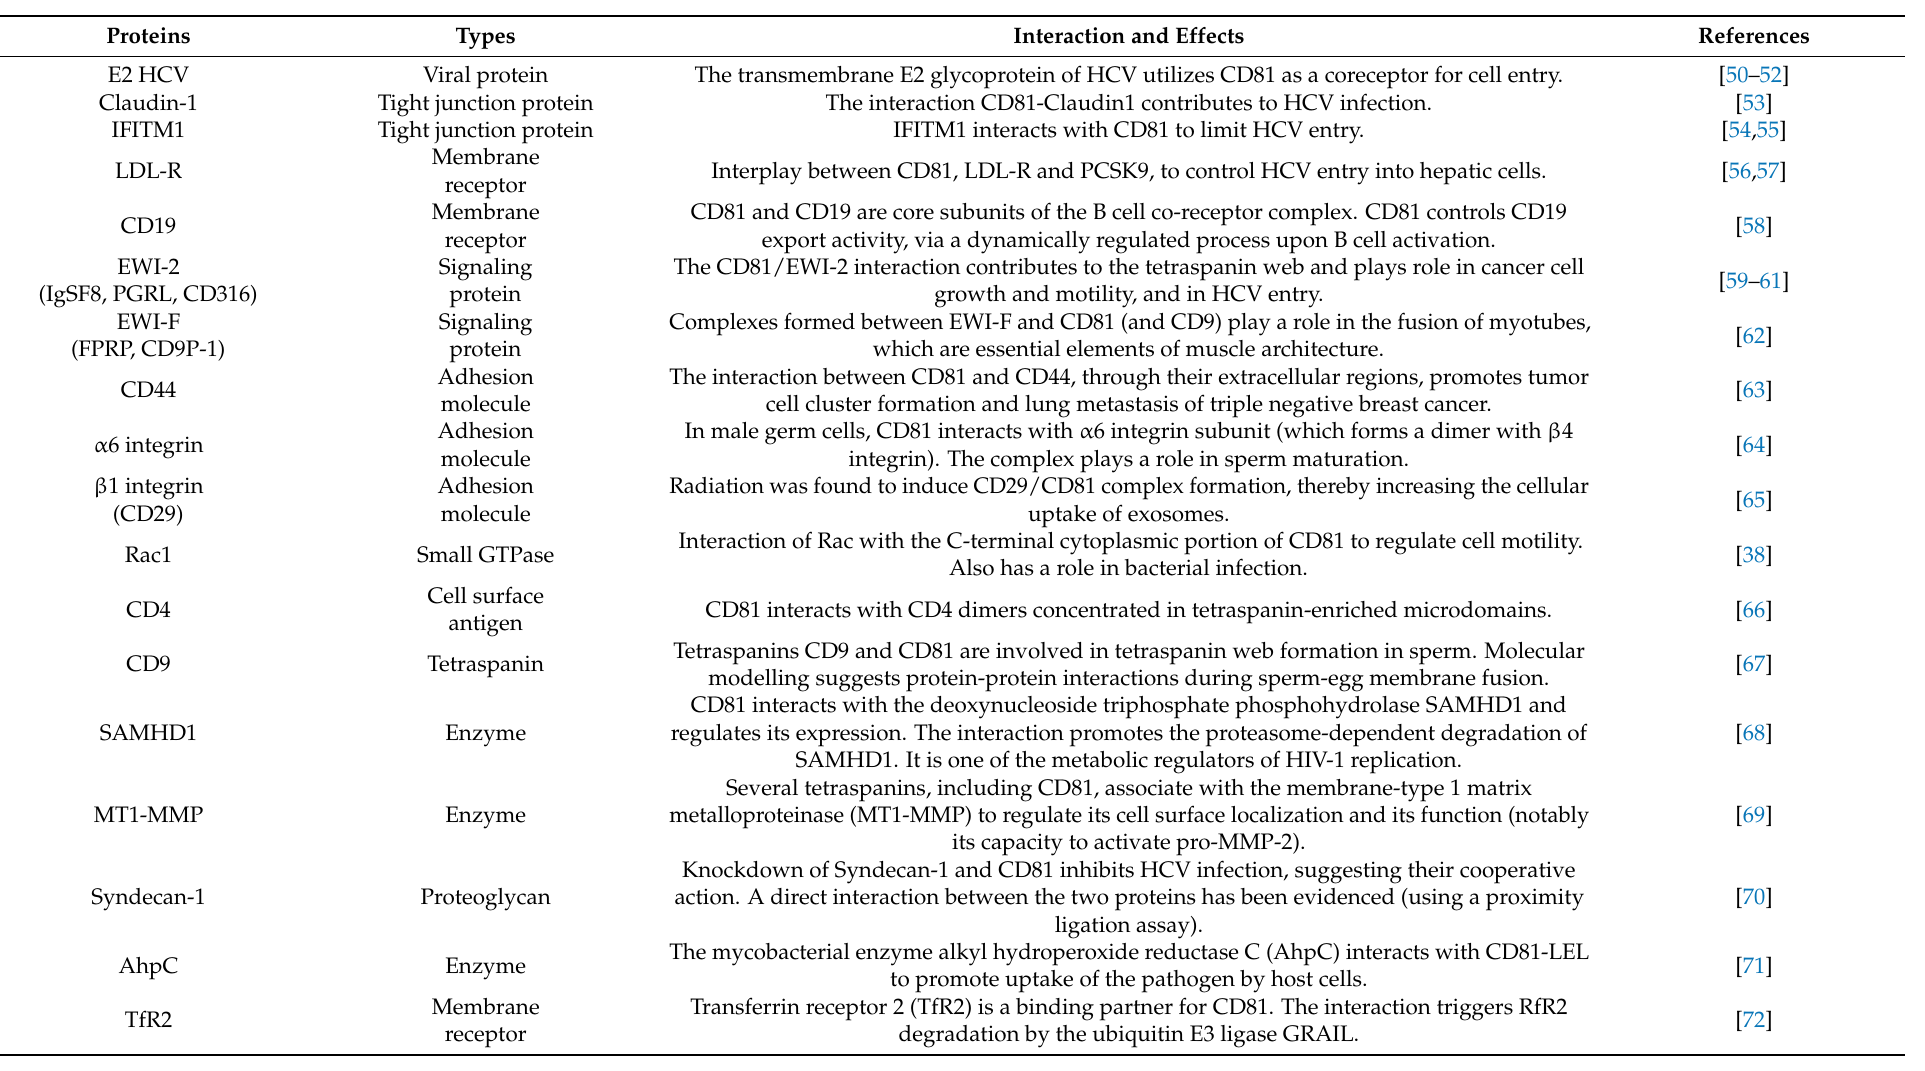
Table 1. Proteins interacting with